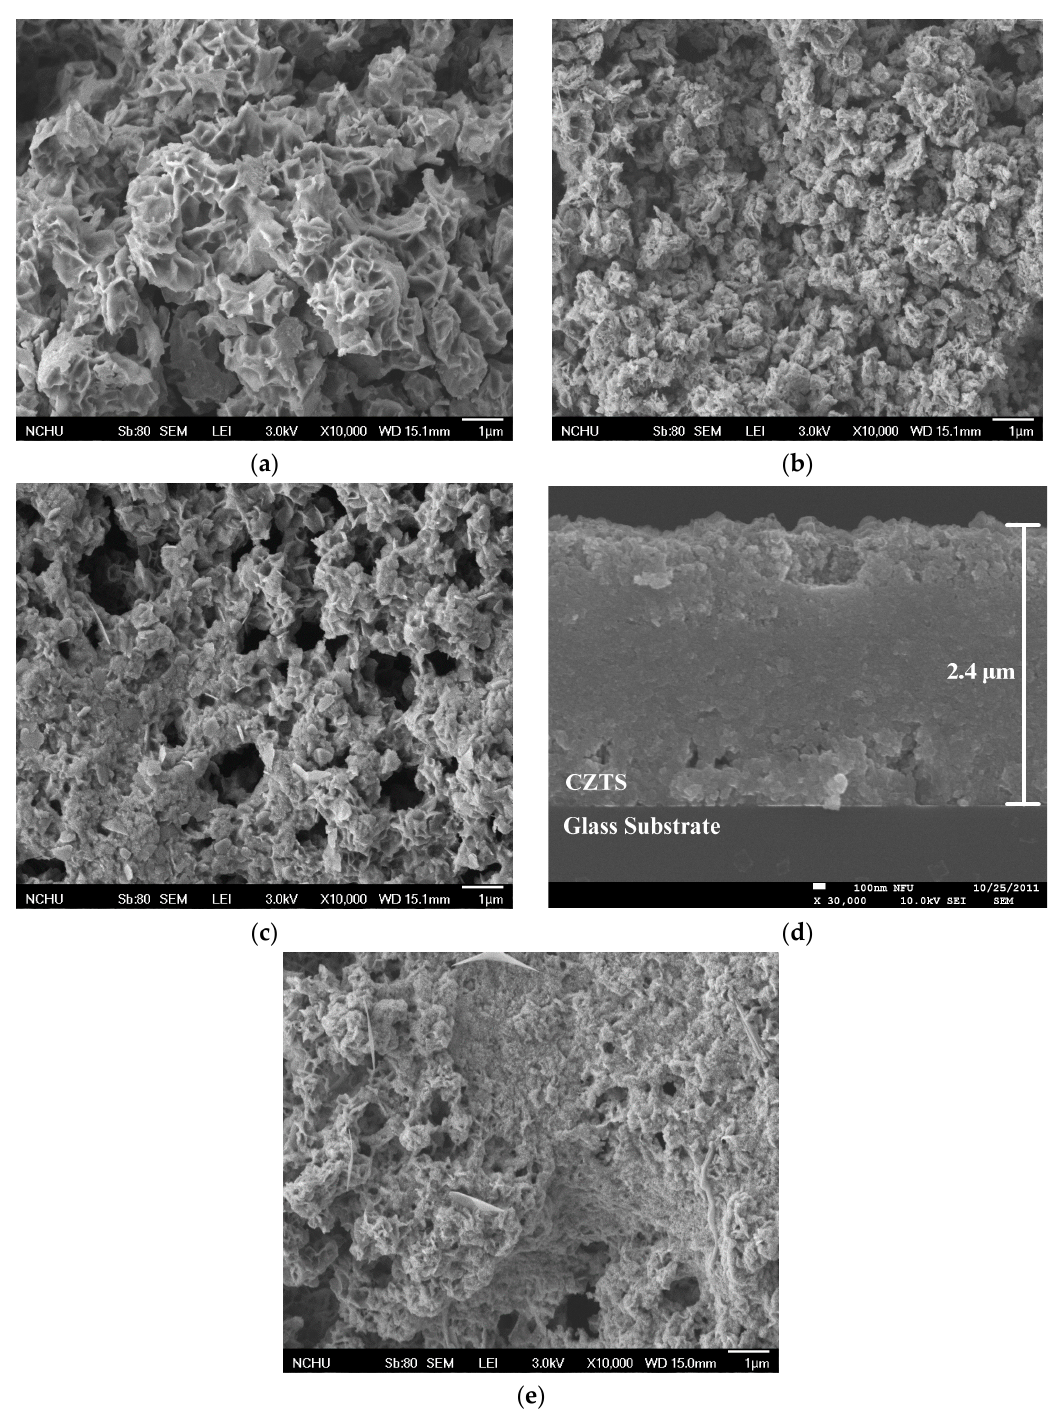
Figure 4. Plane-view field-emission scanning electron microscopy (FE–SEM) images of CZTS thin films deposited with ZnCl 2 , SnCl 2 , and thiourea concentrations of 0.07, 0.07, and 0.8 M, respectively, and CuCl 2 concentrations of ( a ) 0.1 M; ( b ) 0.14 M; and ( c ) 0.16 M, respectively. The cross section image of a CZTS thin film with CuCl 2 , ZnCl 2 , SnCl 2 , and thiourea concentrations of 0.14, 0.07, 0.07, and 0.8 M is represented in ( d ). A CZTS thin film fabricated with ZnCl 2 , SnCl 2 , CuCl 2 , and thiourea concentrations of 0.1, 0.07, 0.14, and 0.8 M, respectively, is shown in ( e ).